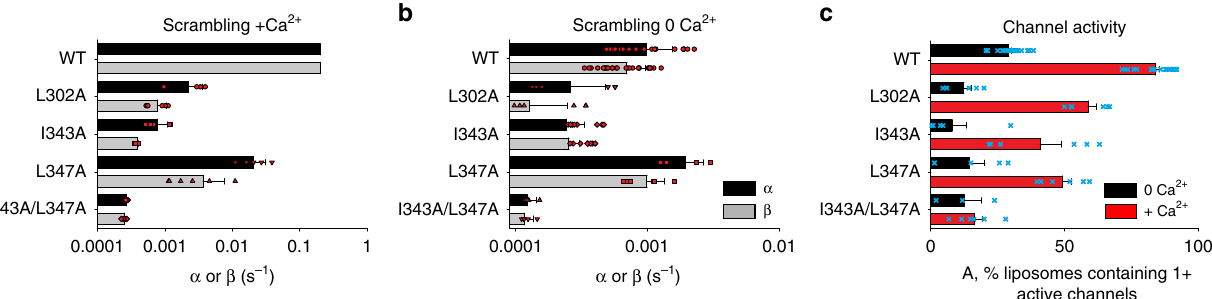
Fig. 6 Functional consequences of mutations at the TM3/TM4 interface. a , b Quanti fi cation of forward ( α ) and reverse ( β ) scrambling rate constants for WT and mutant nhTMEM16 in the presence ( a ) and absence of Ca 2 + ( b ) determined by fi tting fl uorescence traces to Eq. 1 ( “ Methods ” ). For the WT protein in the presence of Ca 2 + the rate constants could not be determined and were constrained to be 0.2 s − 1 as previously described 21,52 . c Quanti fi cation of the fraction of liposomes containing at least one active ion channel in the presence (red) and absence (black) of Ca 2 + using Eq. 3 ( “ Methods ” ). Error bars represent S.D. and the values of individual experimental replicates are indicated as symbols. n = 4 – 20 from 2 +